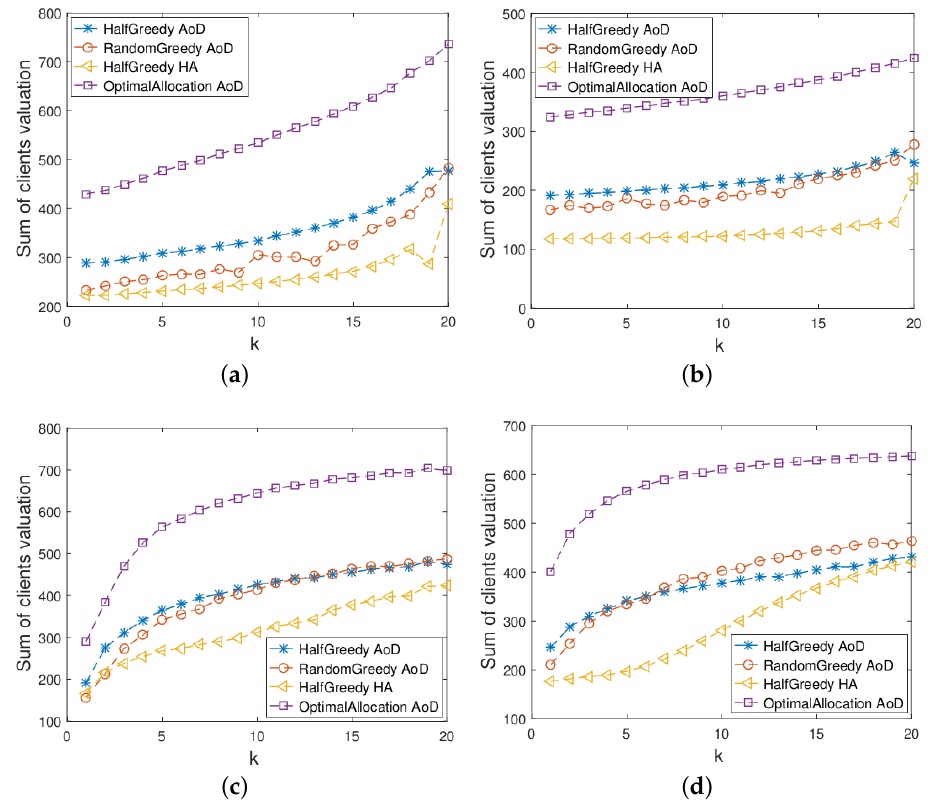
Figure 3. Social welfare comparison for four mechanisms in four data settings. The proposed mechanisms with availability on demand (HalfGreedy AoD and RandomGreedy AoD) always obtain higher social welfare than the mechanism with highest availability (HalfGreedy